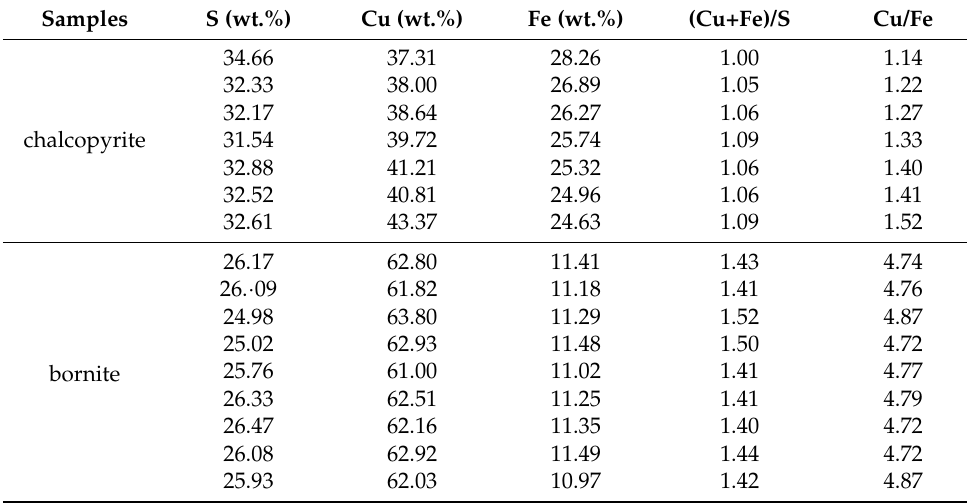
Table 1. EMPA data of sulfides in the 109 Cu deposit (impurities total less than 3%). Samples S (wt.%) Cu